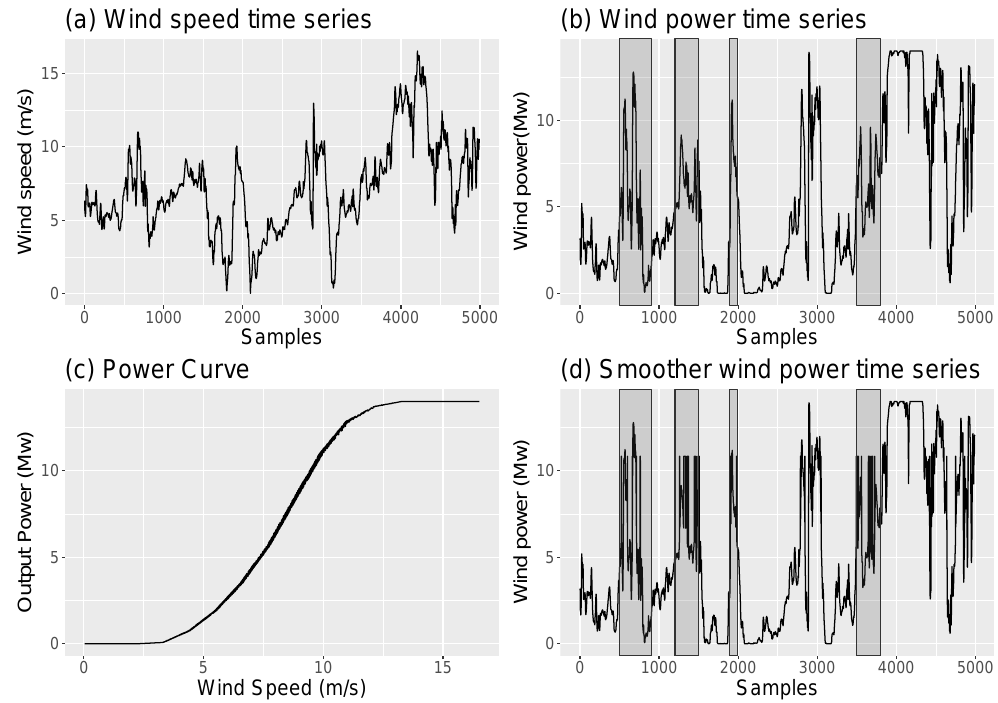
Figure 6. Illustrations of a whole one-year dataset used in the study: initial 5000 samples of ( a ) wind-speed and ( b ) wind-power time series; ( c ) power curve; ( d ) smoother wind-power time series with the proposed method.